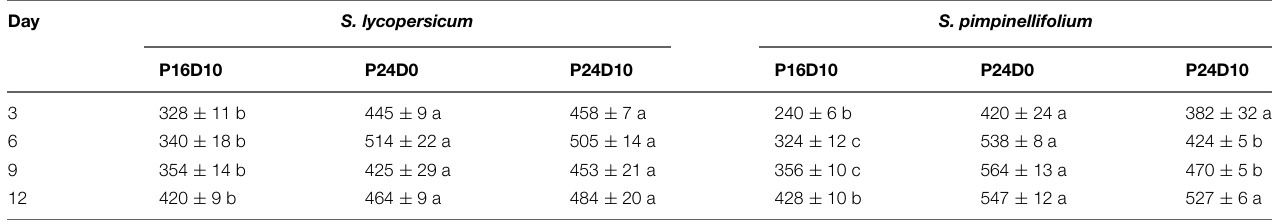
TABLE 3 | The daily carbon gain (mmol CO 2 m − 2 d − 1 ) in two species of tomato grown in three photoperiodic treatments.